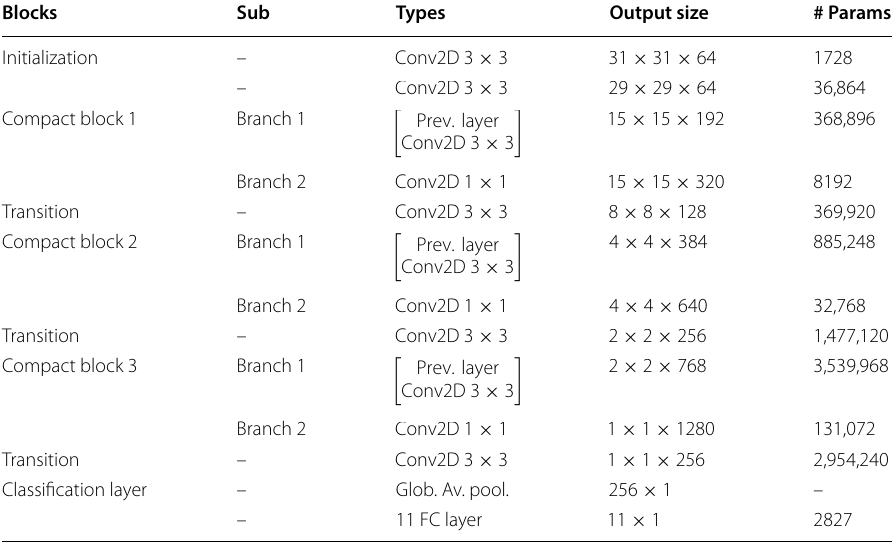
Table 1 Architectures of the proposed model